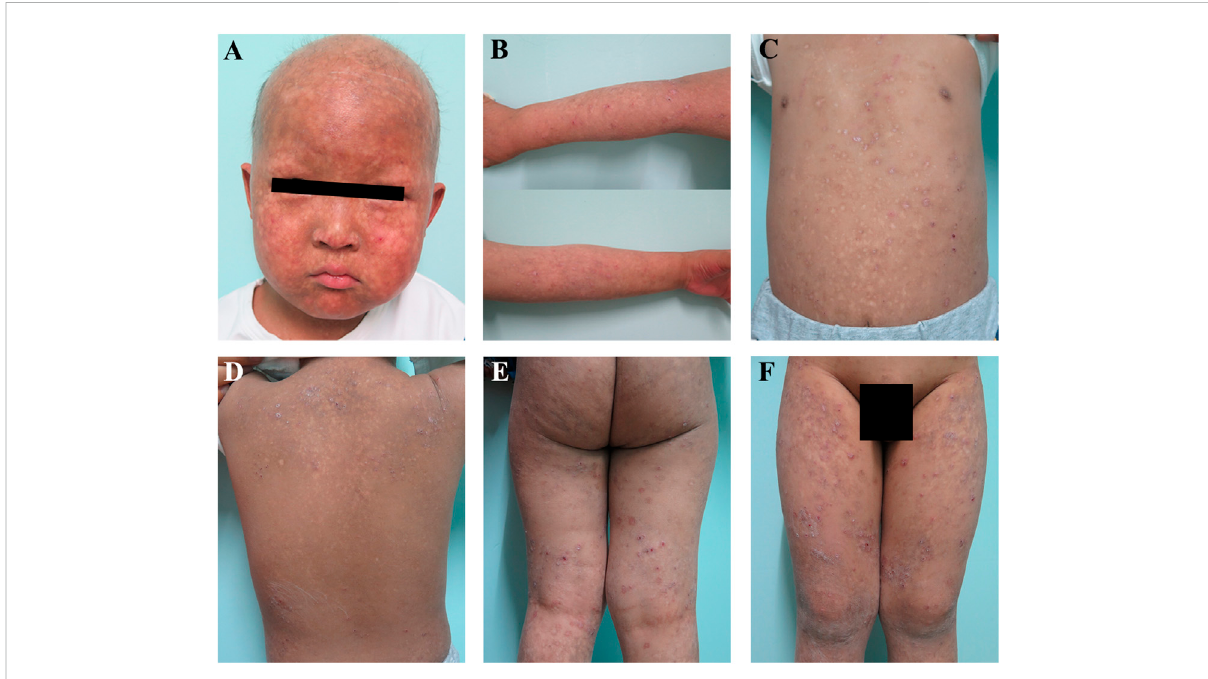
FIGURE 1 Clinical features of the patient (A,B) Congenital poikiloderma, including mottled pigmentation, telangiectasia, epidermal atrophy, sparse scalp hair, as well as absent eyelashes and eyebrows (C – F) The patient also had eczematous lesions on the trunk and